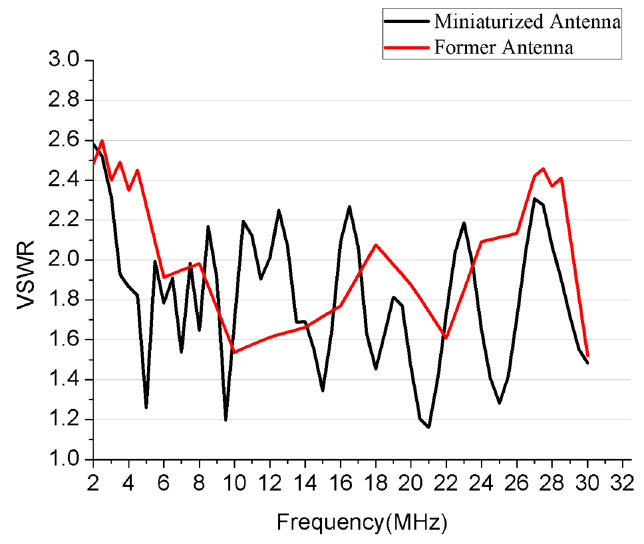
Figure 6. Simulated VSWR of the former antenna and the miniaturized one.